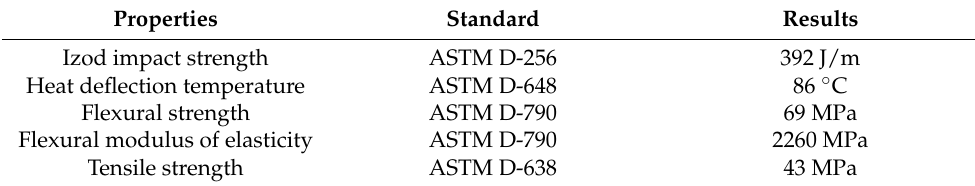
Table 1. Data provided by the manufacturer of ABS AE8000 ® .